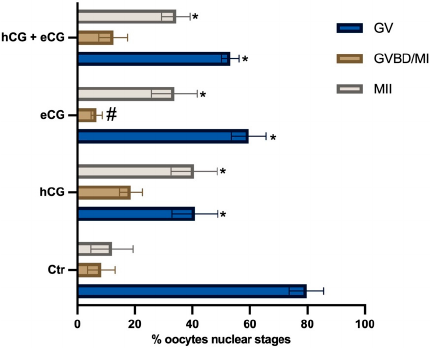
Figure 1. Percentage of meiotic competent IVM EA-derived oocytes: role of chorionic gonadotropin stimulation. Three independent biological replicates were performed for each experimental group (total number of oocytes analyzed: 132, 134, 128, and 130, respectively, for Ctr (without CG), hCG, eCG, and hCG + eCG). Both CGs were used at 5 IU/mL. The signi fi cant data (from p < 0.05) analyzed vs. Ctr (without CG) or vs. 5 IU/mL hCG were indicated with * and # superscripts, respectively. However, the hormonal treatments displayed a di ff erent ability to promote meiosis. Indeed, hCG demonstrated an overall higher e ffi ciency in triggering the resumption of meiosis in EA-derived oocytes (GVBD/MI + MII oocytes: 59.2% hCG vs. 40.4% eCG vs. 46.8% hCG + eCG: for p < 0.05, respectively).